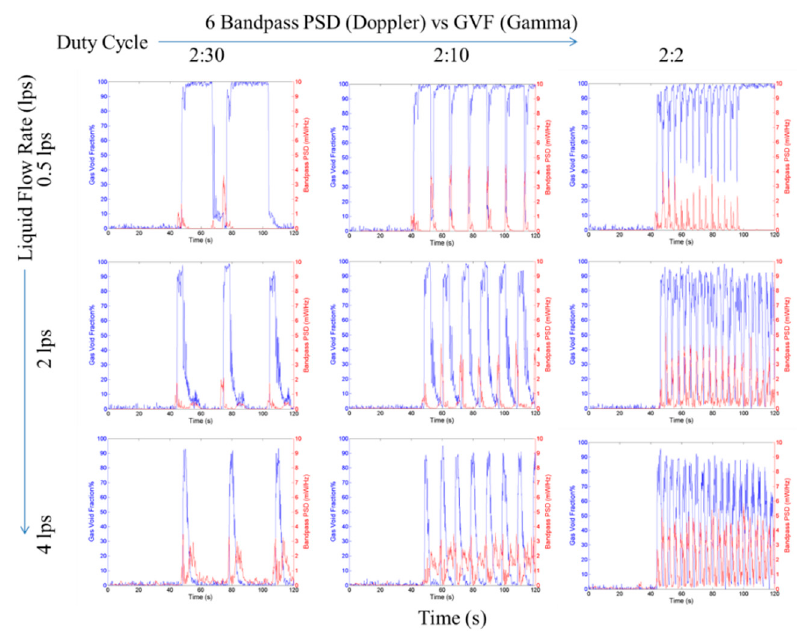
Figure 11. The STFT average bandpass power spectral density (0.95–1.05 kHz) for various slug trains. The gas void fractions (blue lines) are estimated from the gamma densitometer. The Y-axis limits of each plot in this figure are 0 volts to 1 volt and the X-axis limits are 0 s to 120 s.